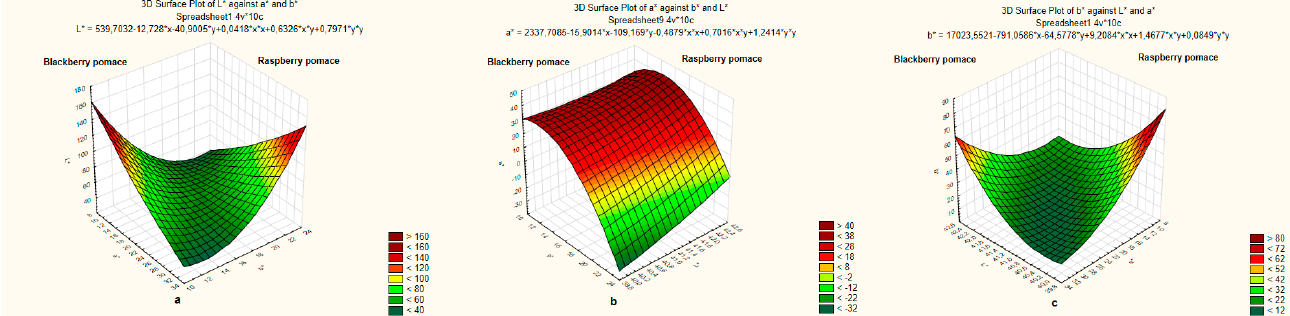
Figure 1. Berries pomace color L* coordinate values ( a ), a* ( b ) and b* ( c )